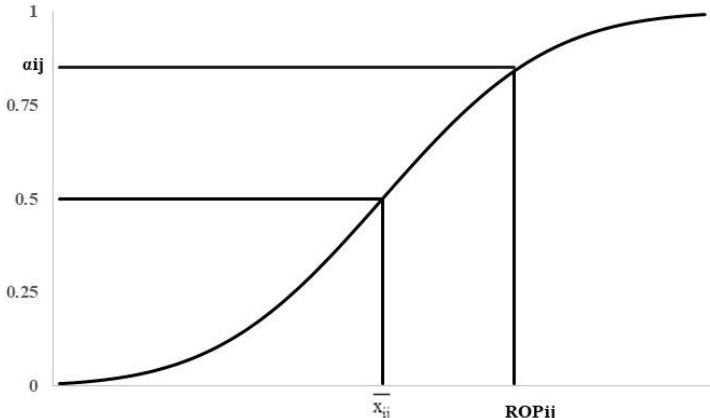
Figure 1. Cumulative normal demand distribution.